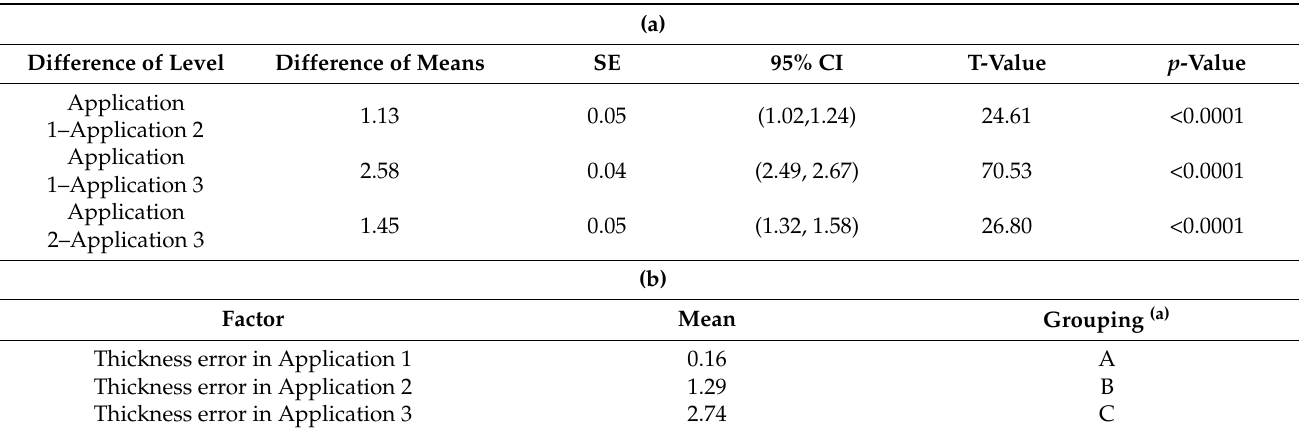
Table 7. (a) Games–Howell simultaneous tests for differences of means. (b) Grouping information using the Games–Howell method and 95% confidence.